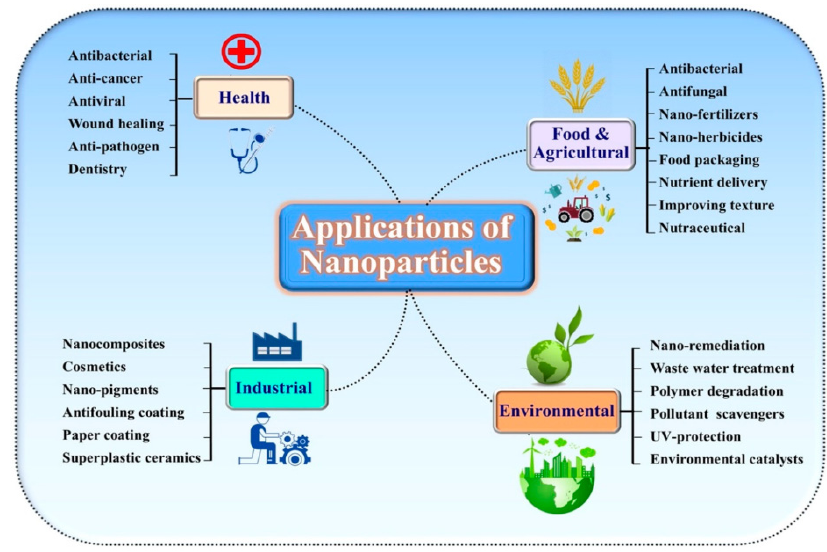
Figure 7. Use of nanoparticles in different fields. Copied from MDPI [143].